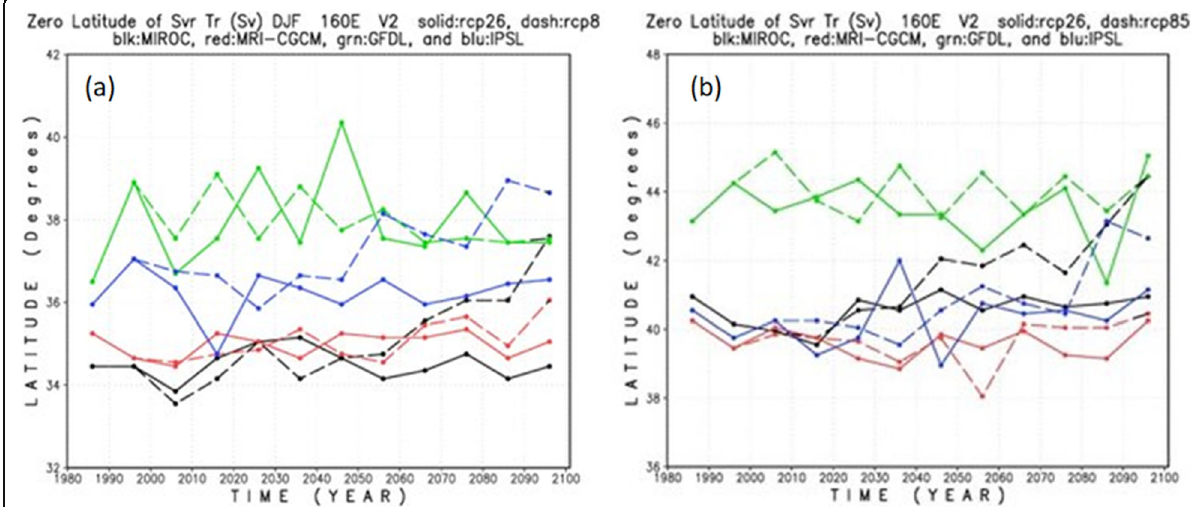
Fig. 5 Time series of zero latitude of Sverdrup transport at 160° E calculated from MIROC5 (black lines), MRI-CGCM3 (red lines), IPSL-CM5A-MR (blue lines), and GFDL-ESM2M (green lines) a winter (December, January, and February) mean and b annual mean wind stress forcing from CMIP5 RCP2.6 (solid lines) and RCP8.5 (dashed lines)